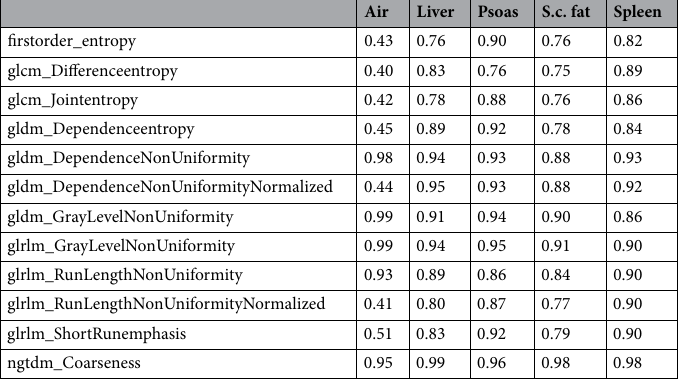
Table 3. Stable features with ICC > 0.75 in > 3 organs between monoenergetic reconstructions for 3D-2 cm